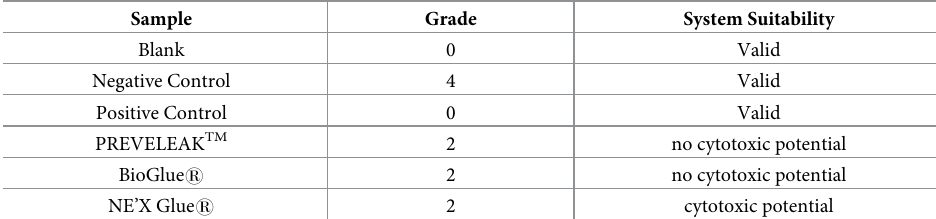
Table 1. Results of cytotoxic potential assessment.